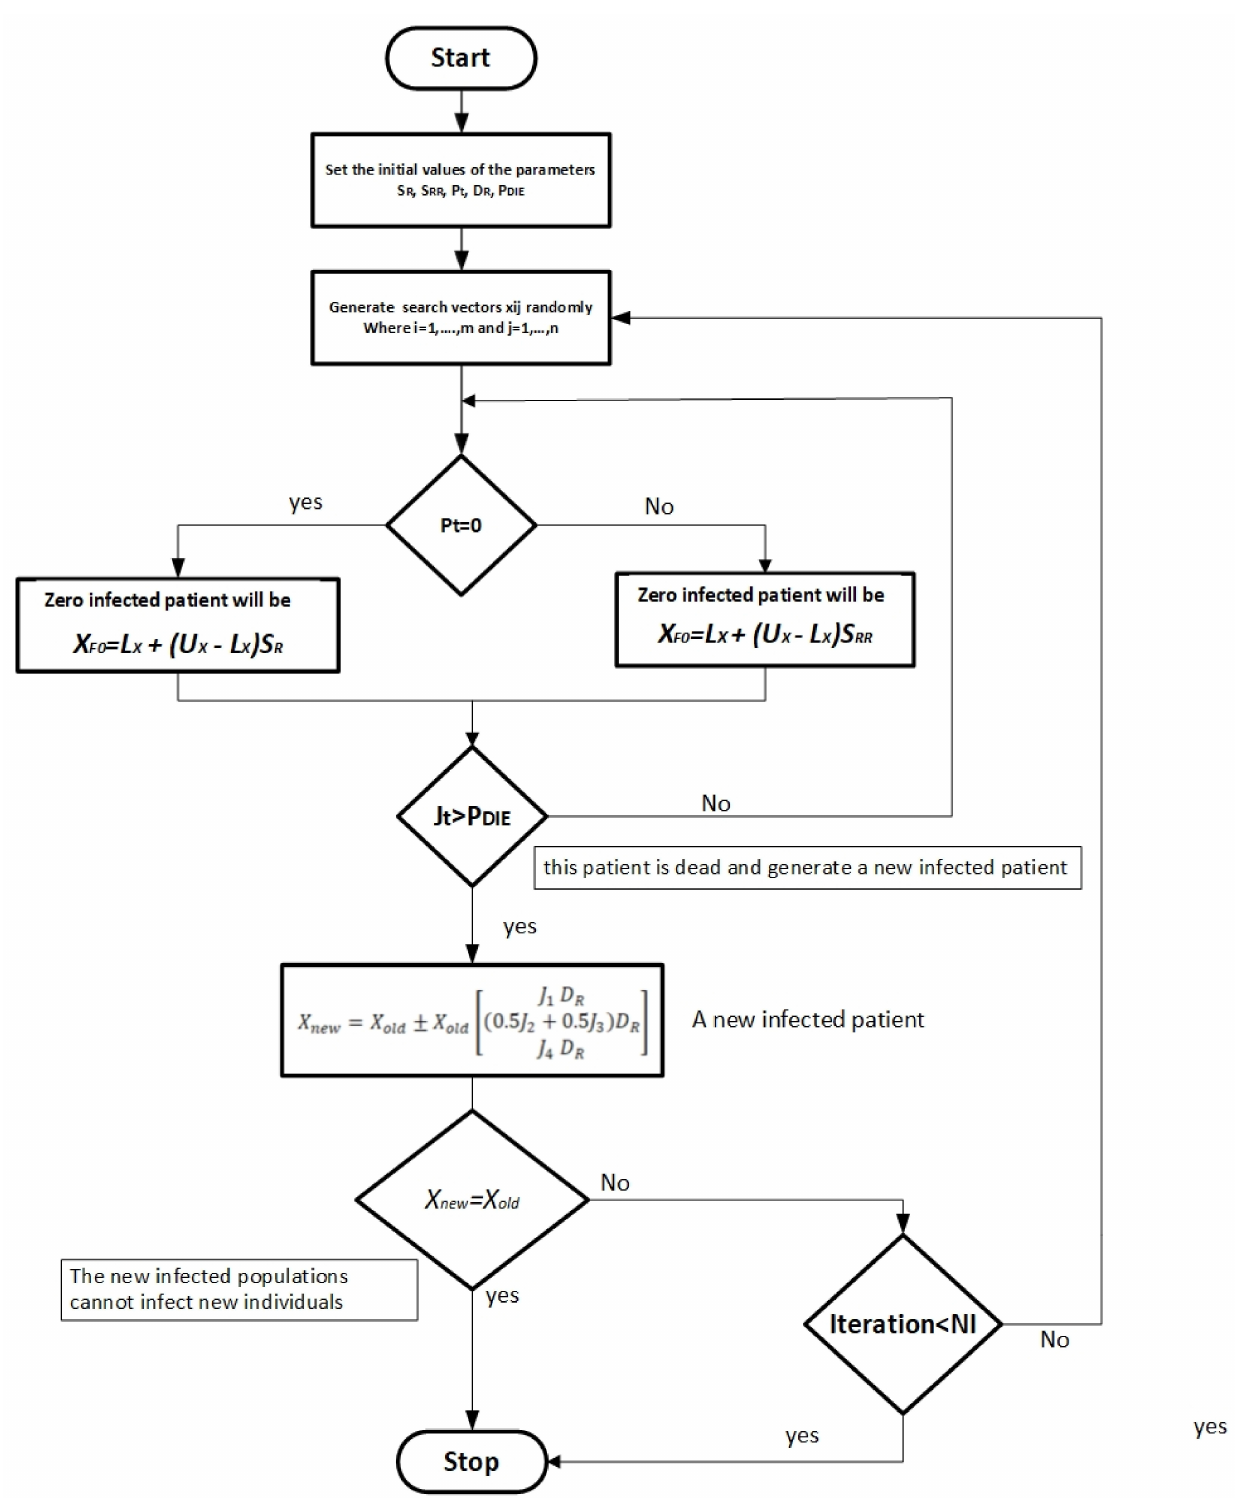
Figure 6. The CVOA flow